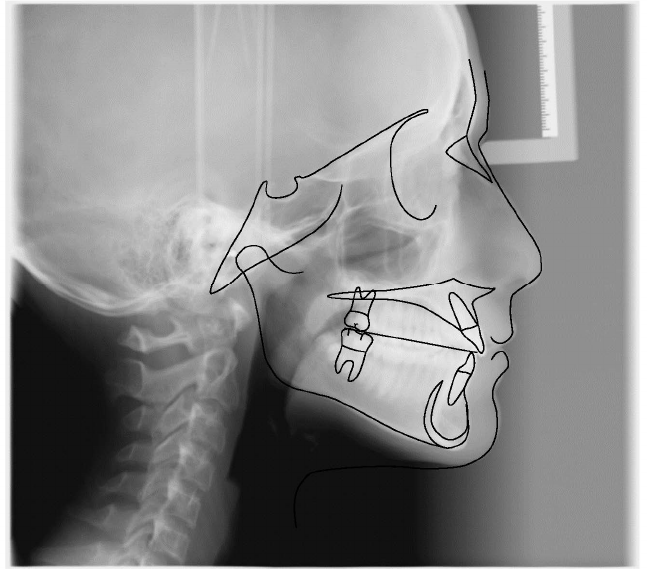
Figure 37. Cephalometric tracing (DeltaDent software) after treatment and a 3-year follow-up period (12-year-old). Table 8. Cephalometric analysis after treatment and a 3-year follow-up period.